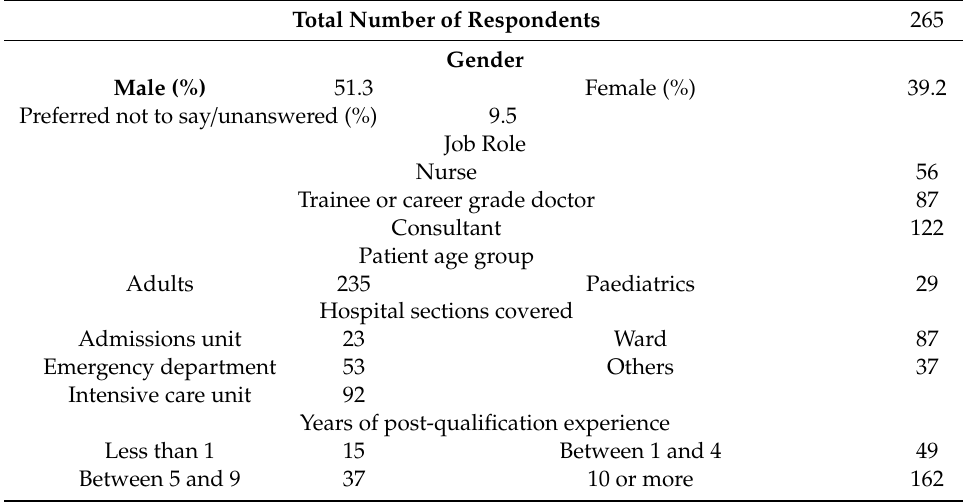
Table 1. Characteristics of respondents to online